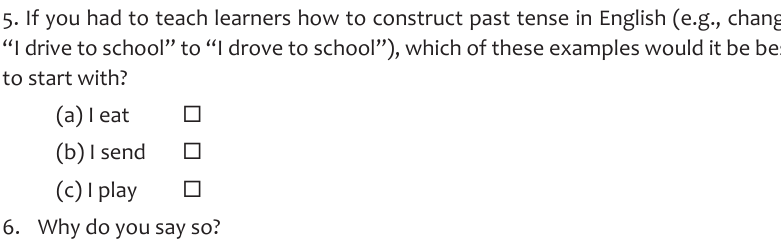
Figure 5: Example of question on exemplifying for English